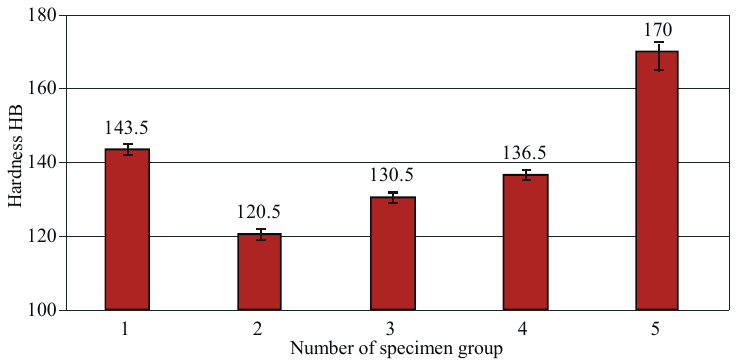
Figure 8. Effect of the heat treatment on hardness of Cu-10Al-5Fe bronze: 1—as received, 2—annealed, 3—quenched, 4—quenched and tempered at 600 °C, 5—quenched and tempered at 300 °C.